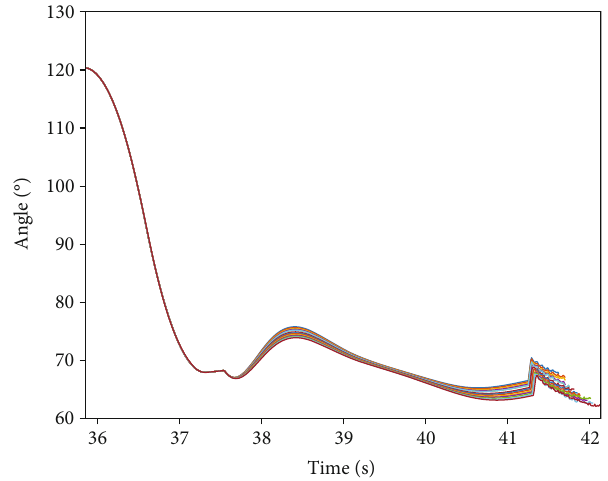
Figure 5: Twelve optimal joint angle trajectories for joint 2 of the left manipulator.